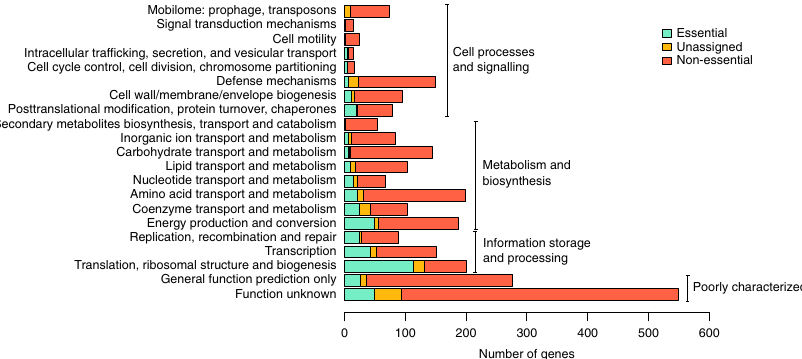
Fig. 2 arCOG category and essentiality criteria for protein-coding genes in S. islandicus M.16.4. Functional distribution of essential, non-essential, and unassigned genes via arCOG category. Essentiality criteria based on cutoffs in Fig.